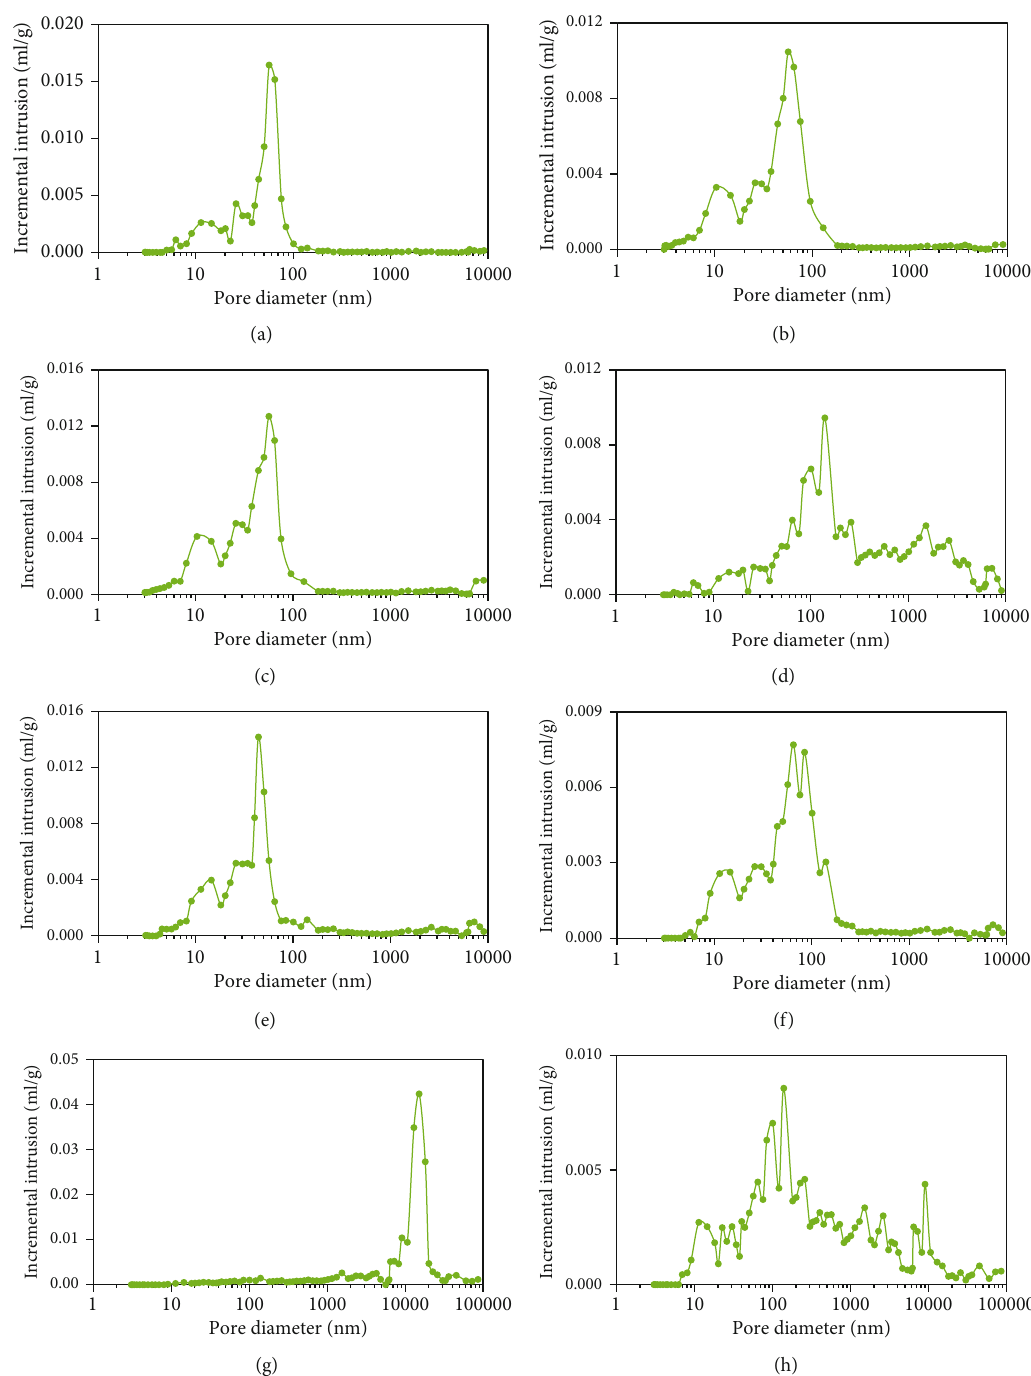
Figure 8: HPMI pore volume distribution of typical Qigequan Formation mudstone samples. (a) H-1: pure mudstone; (b) H-2: pure mudstone; (c) H-3: pure mudstone; (d) H-4: silty mudstone; (e) H-5: silty mudstone; (f) H-6: silty mudstone; (g) H-7: sandy mudstone; (h) H-8: sandy